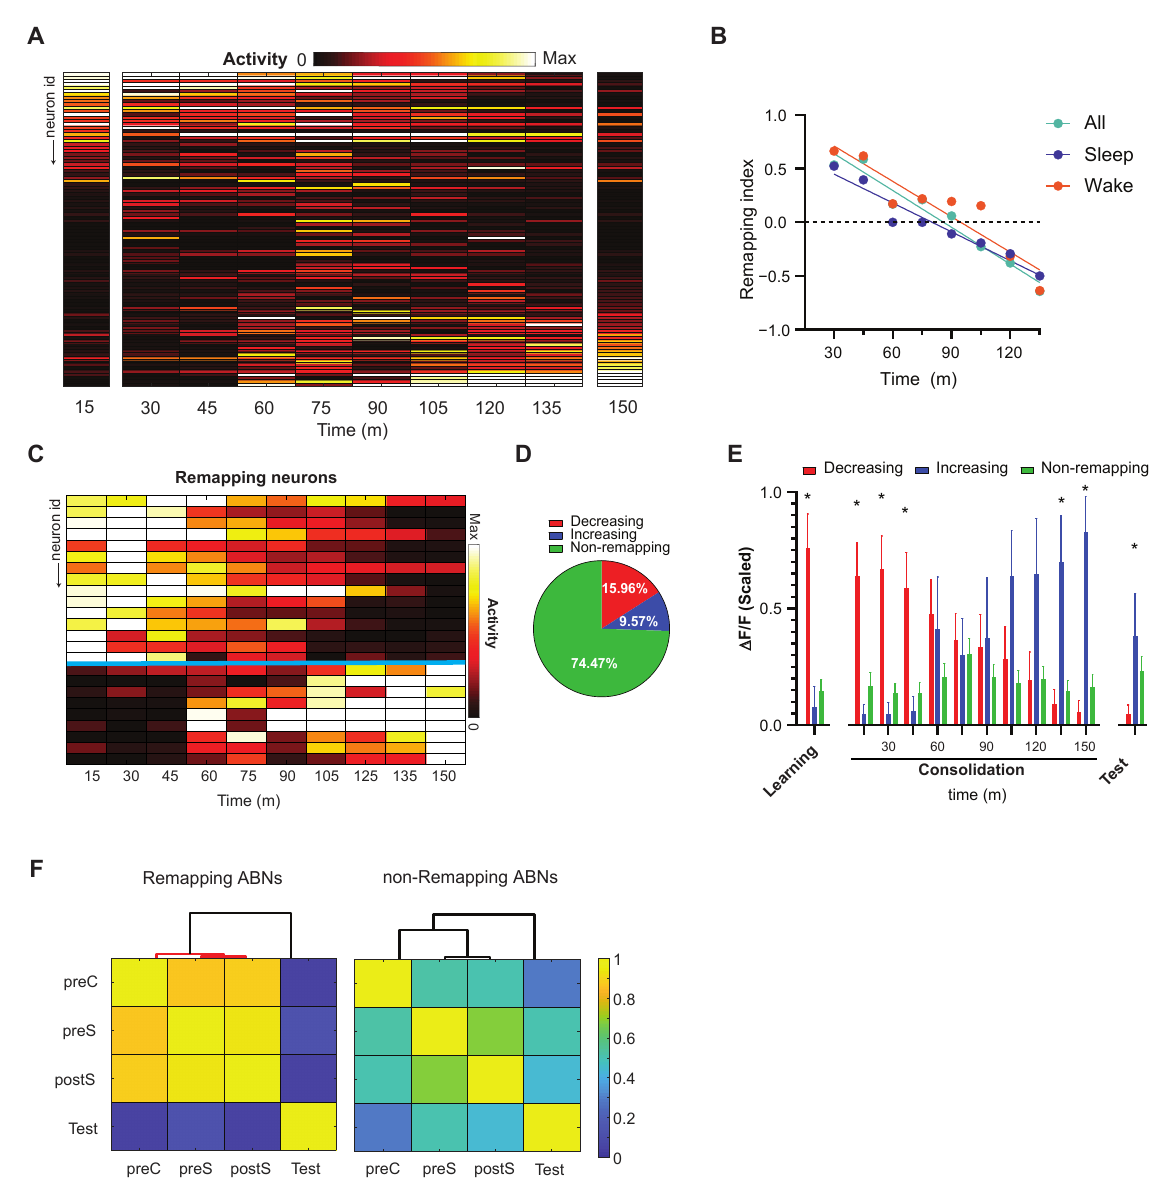
consolidation [16]. This population of ABNs that is reactivated during REM sleep overlaps with the population of ABNs decreasing their activities during the consolidation period (Figure S1C). This suggests that reactivation during REM and activity remapping may be linked phenomena, although causality is yet to be demonstrated. Fig. 3